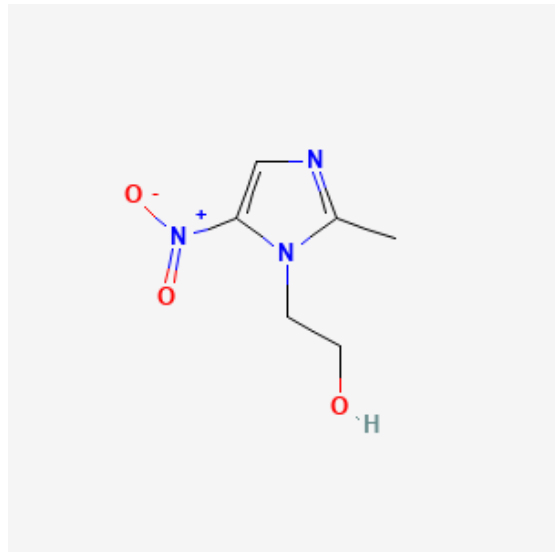
Figure 3. 2D chemical structure of metronidazole.